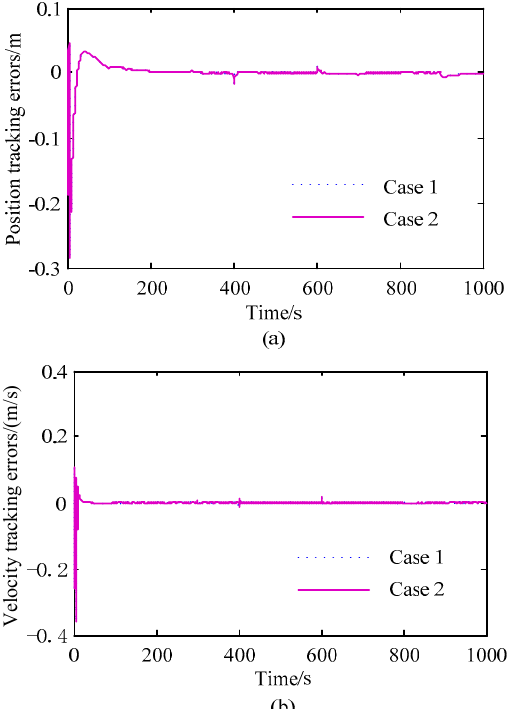
Figure 8. Control performance for HSTs with larger lumped uncertainty: ( a ) position tracking error, ( b ) velocity tracking error.